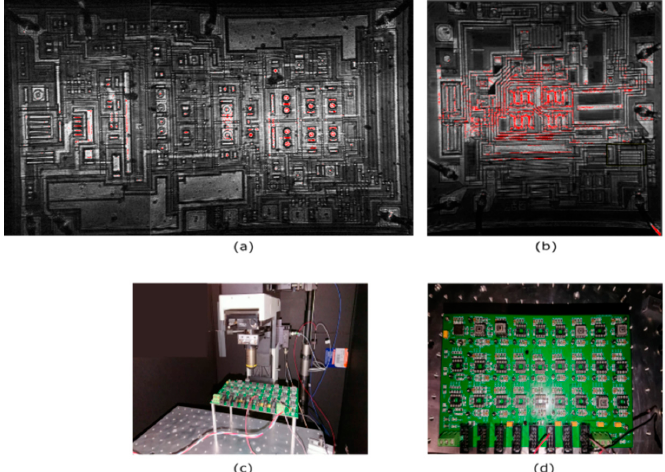
Figure 12. ( a ) Profile of OP77; ( b ) profile of AD711; ( c ) actual op-amps testing system; ( d ) actual op-amps testing board.